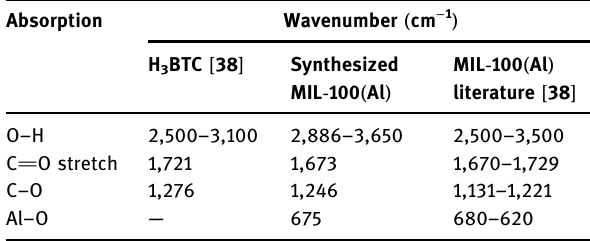
Table 1: Comparison of the absorption spectra of the